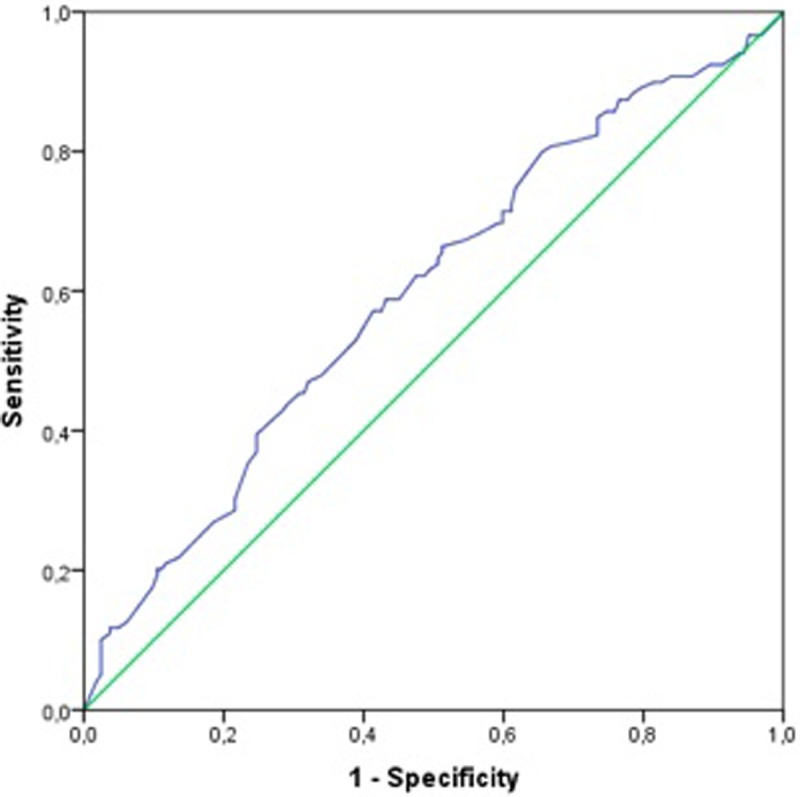
ROC curve for GW.